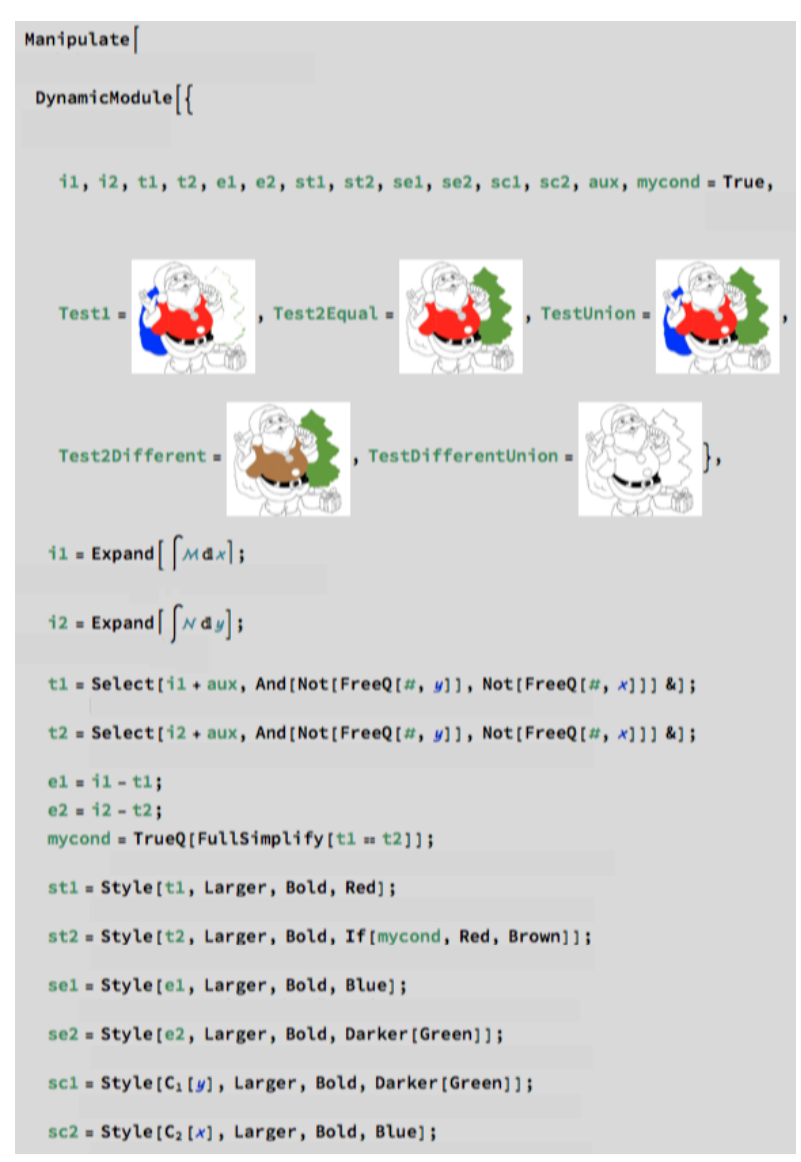
Figure 2. Part of the code of the tool “Christmas Scene Method for identifying and solving exact differential equations”, used in the examples presented in Figures 8, 16 and